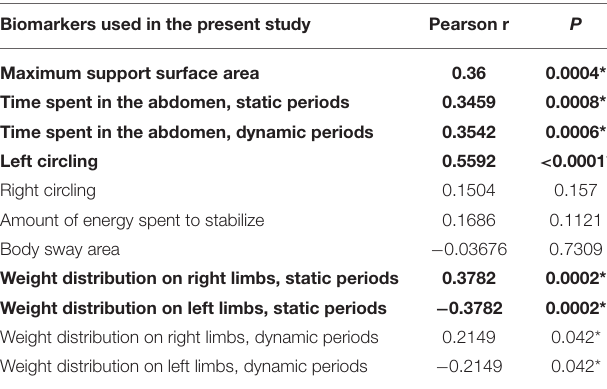
TABLE 1 | Correlations between the results of qualitative behavioral assessment and the results of quantitative behavioral assessment of vestibular syndrome. Biomarkers used in the present